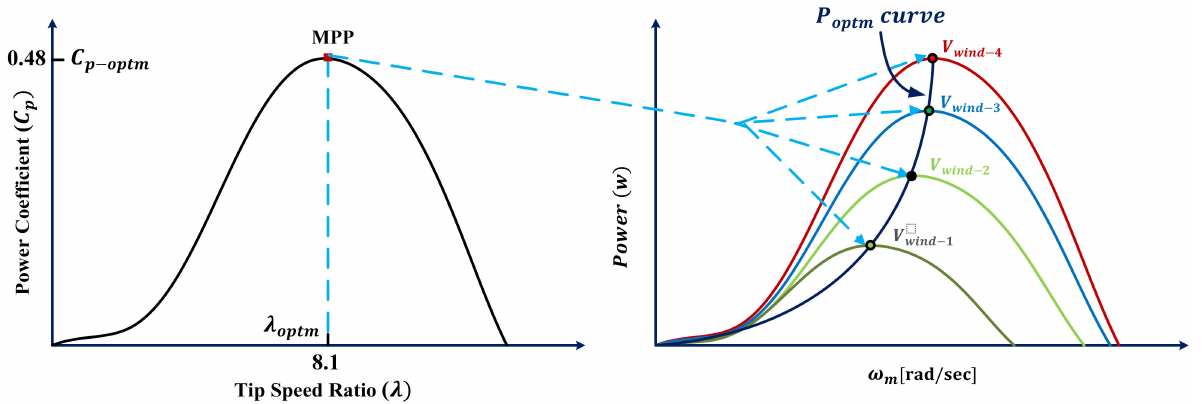
Figure 3. Power characteristic curve